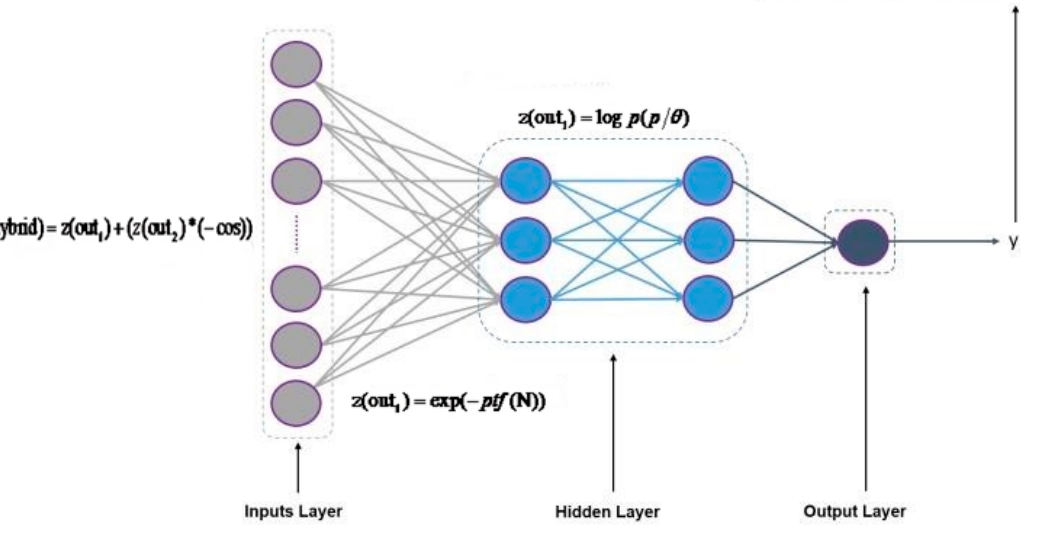
Figure 2. Integrating a non-linear with MLP.